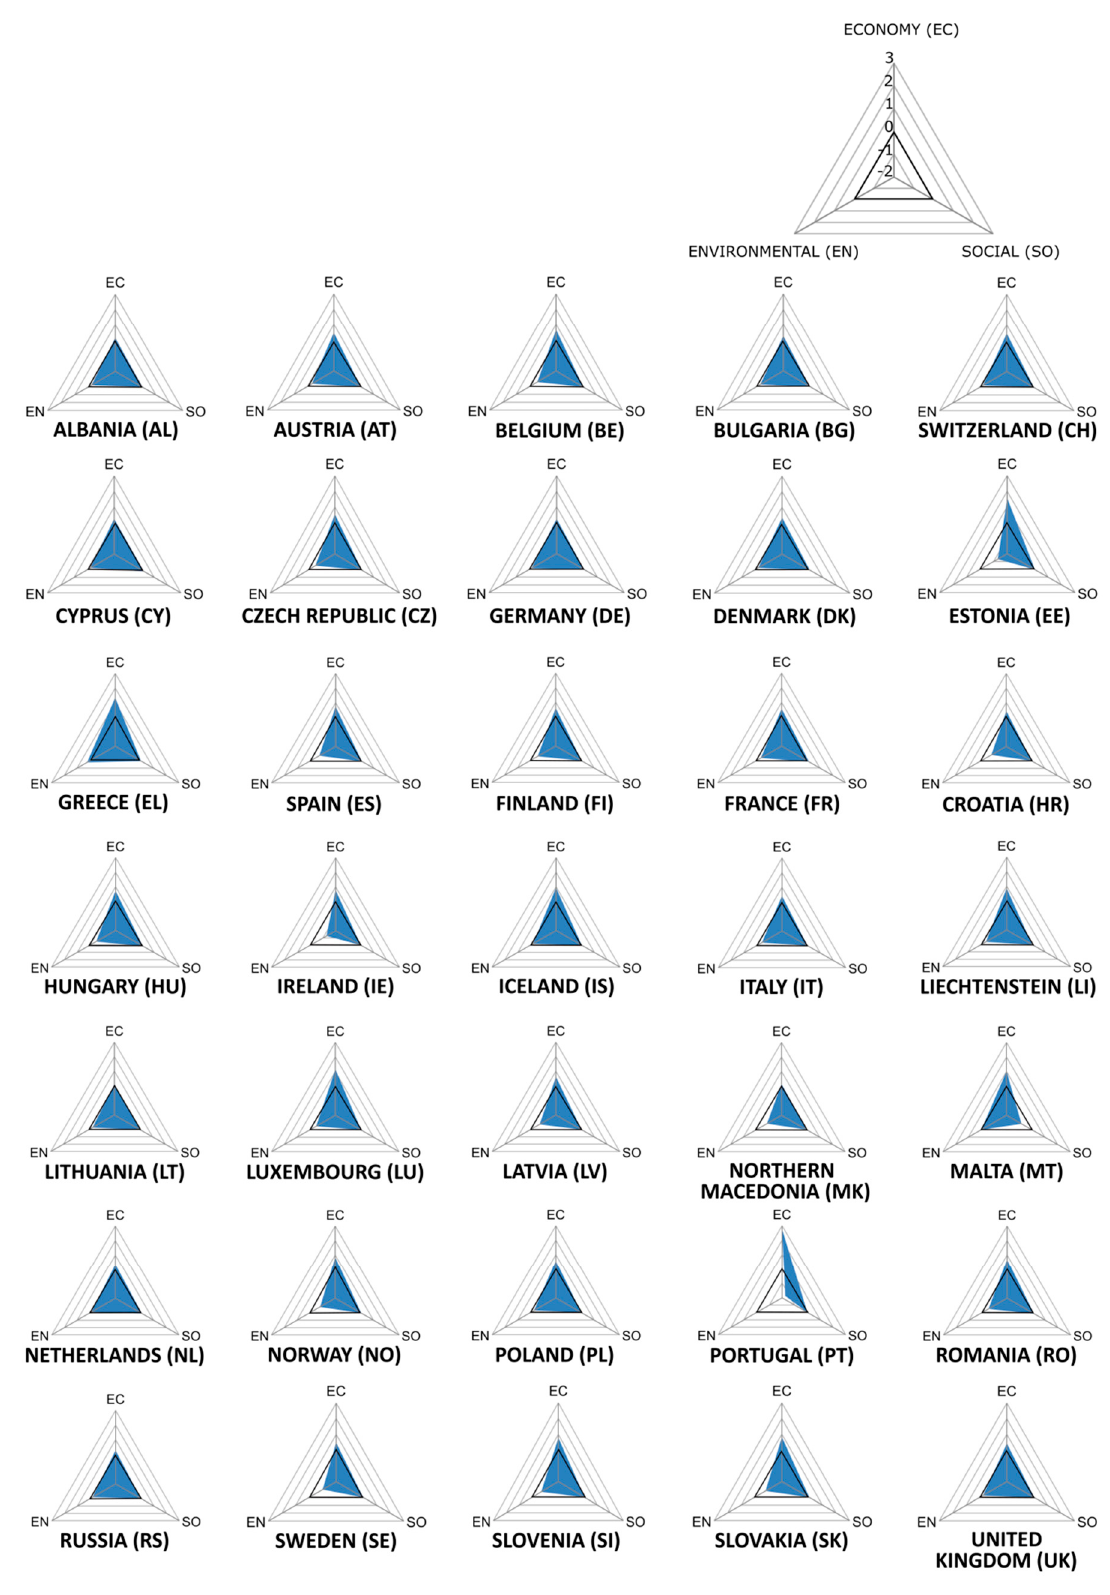
Figure A6. Sustainability assessment of local change directions in country - DEGURBA level 2